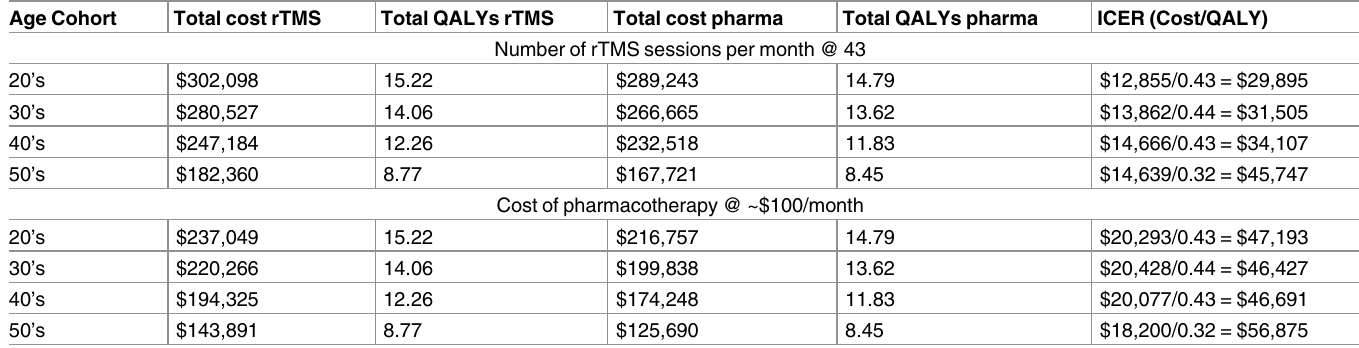
Table 4. Incremental Cost Effectiveness Ratios [ICER] (Incremental cost rTMS vs. pharmacotherapy divided by the incremental benefit rTMS vs. pharmacotherapy)–assuming upper end of the number of treatments in order to have a response to rTMS and; assuming the cost of pharmaco- therapy @